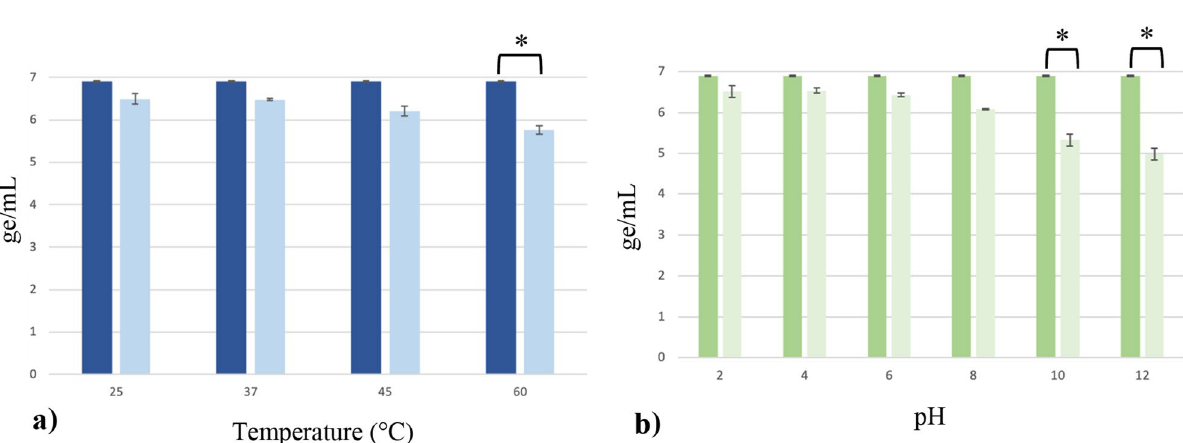
Figure 2. ( a ) Temperature ( b ) pH stability results of phage vB_EcoS_ULI-O80_Stx2d after 1 h. The means of three experiments (± σ) are represented and the concentrations measured before testing are represented by the dark bars. p value (*) ≤ 0.05. ge genomic